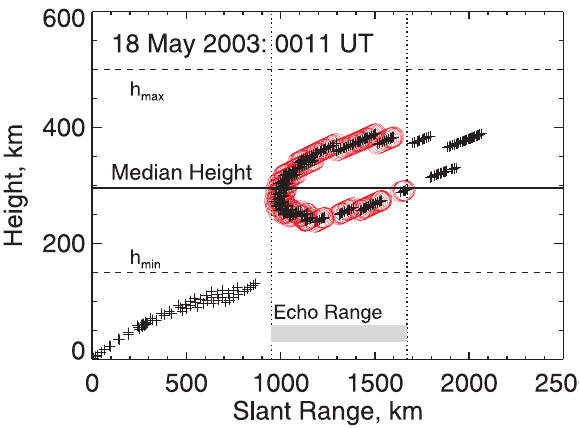
Fig. 4. Diagram illustrating the method of echo height estimation for the event of 18 May 2003, 00:11